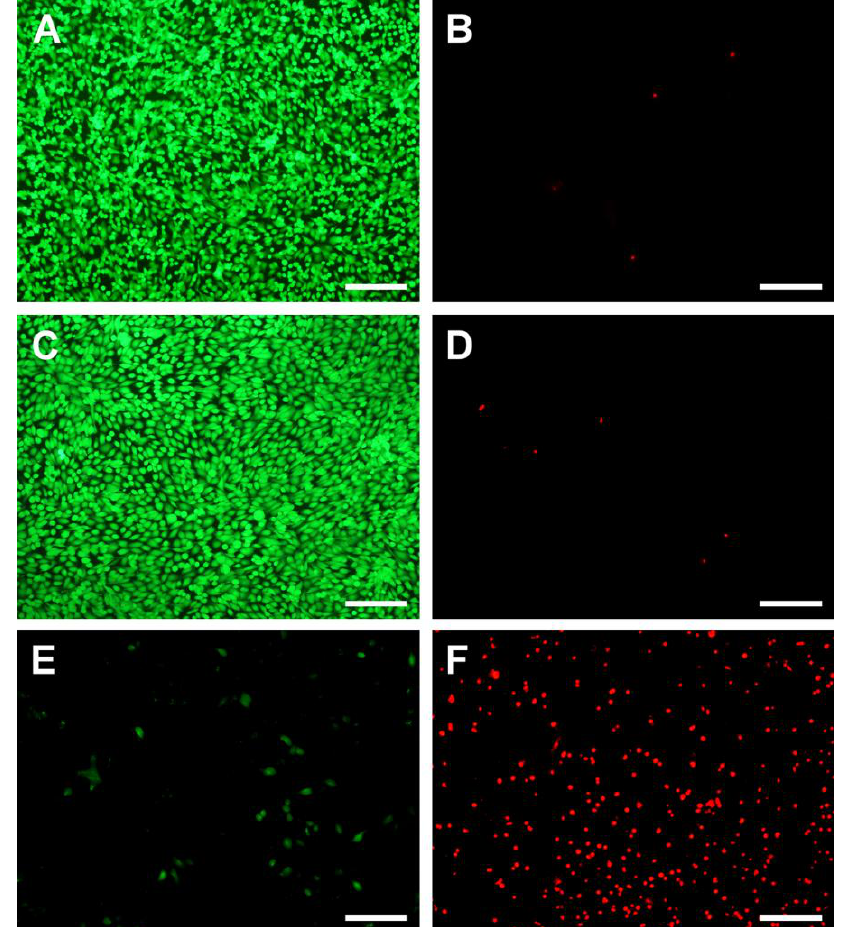
Figure 4. Cell viability of ARPE-19 cultures was determined by staining with Live/Dead Viability/Cytotoxicity Kit in which the live cells fluoresce green and the dead cells fluoresce red. Green ( A , C , E ) and red ( B , D , F ) fluorescence images of cells after exposure to 5 mg of different types of chitosan membranes (A, B) Chi, (C, D) GP-chi, and (E, F) GTA-chi for 3 days at 37 °C. Scale bars indicate 100